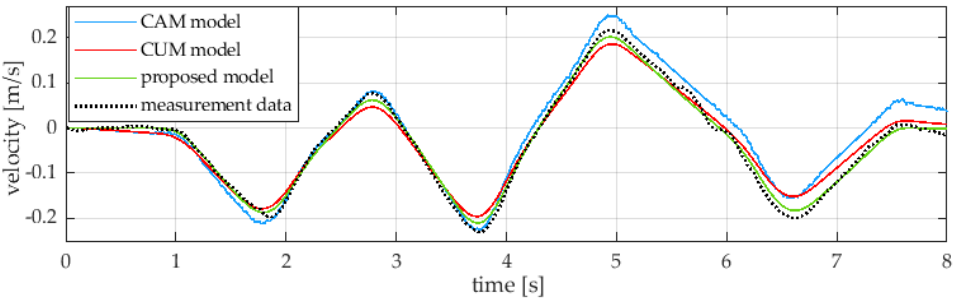
Figure 7. Ball velocity as a function of time and comparison of waveforms from experimental data and numerical models.